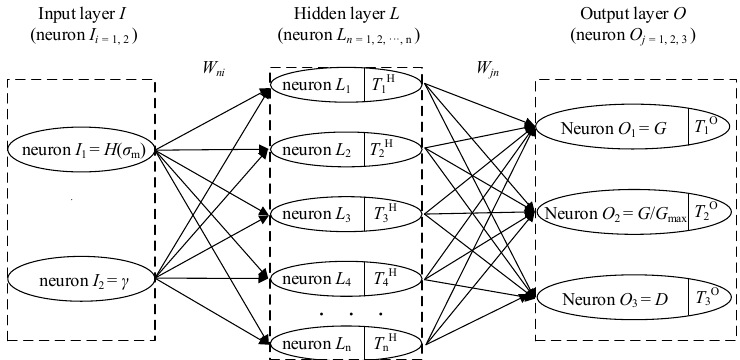
Figure 6. Technical framework for the intelligent